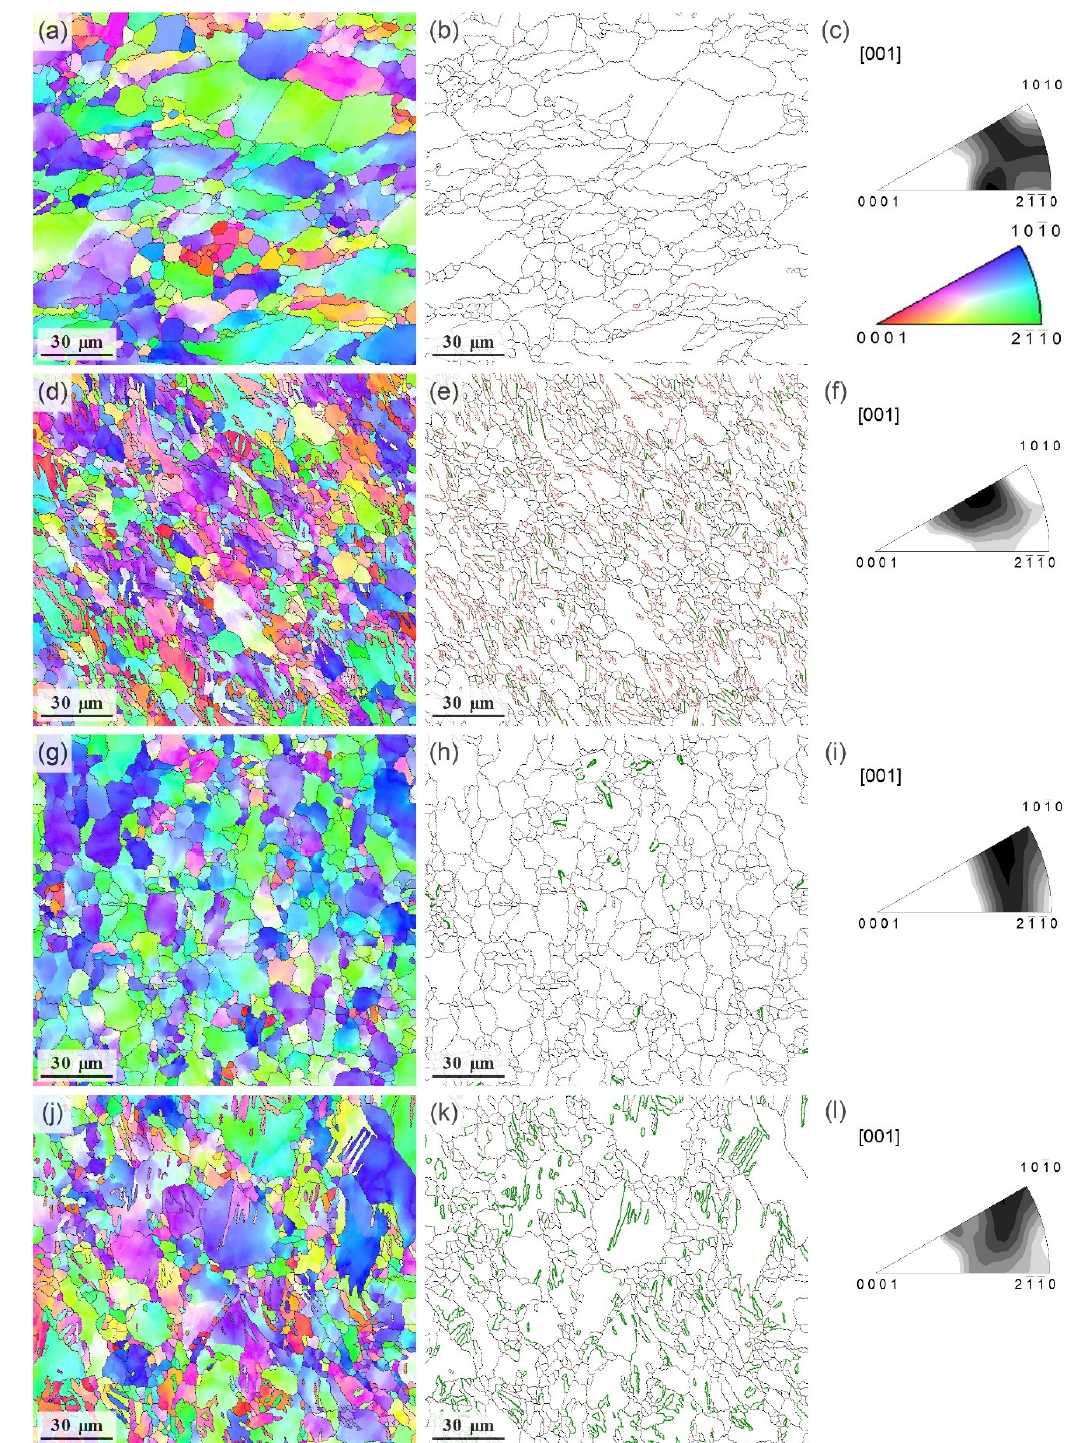
Figure 11. Results of the EBSD analysis of the deformation microstructure for the Mg-1Zn-0.2Ca alloy tested in tension at 200 °C to different strains (all maps have been obtained for the planes normal to the longitudinal axis of the specimens): ( a – c ) initial structure ε = 0, ( d – f ) ε = 3%, ( g – i ) ε = 5%, and ( k – m ) ε = 10%; ( a , d , g , j ) EBSD maps are coded in IPF colours shown in ( c ); ( b , e , h , k ) show the high-angle grain boundary maps with the highlighted (by the red colour) ranged be- tween 85 and 95°, the tension twins are highlighted by green; ( c , f , i , l ) IPF pole figures indicating the texture evolution with straining.